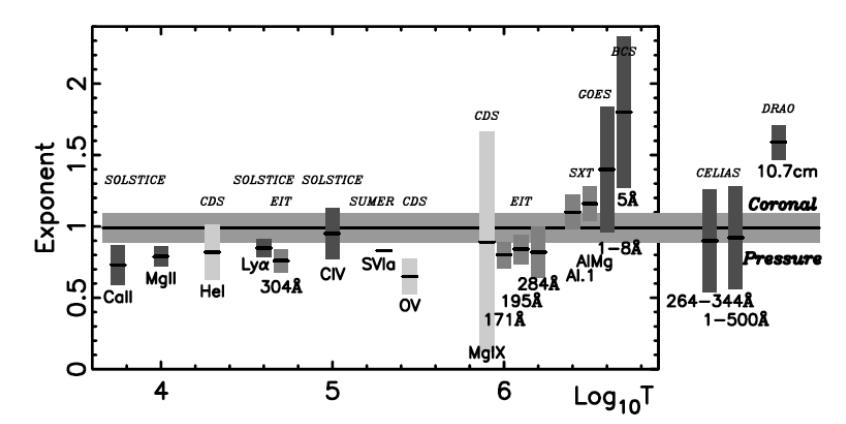
Figure 31: Ranges for the exponents, b, found for the power-law relations between the detected excess flux density and the magnetic flux density in different spectral domains, Δ 𝐹 ∝ ¯ 𝐵 𝑏 . The results are approximately ordered along the abscissa according to the mean temperature of the emitting plasma (except when the ranges overlap, e.g., in X-rays). Results at the extreme right, outside of the box, have such a broad wavelength (temperature) range that a mean temperature cannot be defined. The ordinate extension of the shaded regions represent the ± 3 𝜎 error range. The Sun-as-a-star measurements are dark shaded, while the spatially resolved measurements are light shaded, with the lightest shading for the spectrometers (CDS, SUMER). The horizontal grey band corresponds to the range of the exponent for the coronal plasma pressure. In the X-ray range, the exponents are corrected for the temperature dependence of the instrumental response function. Image reproduced with permission from D´emoulin (2004), copyright by